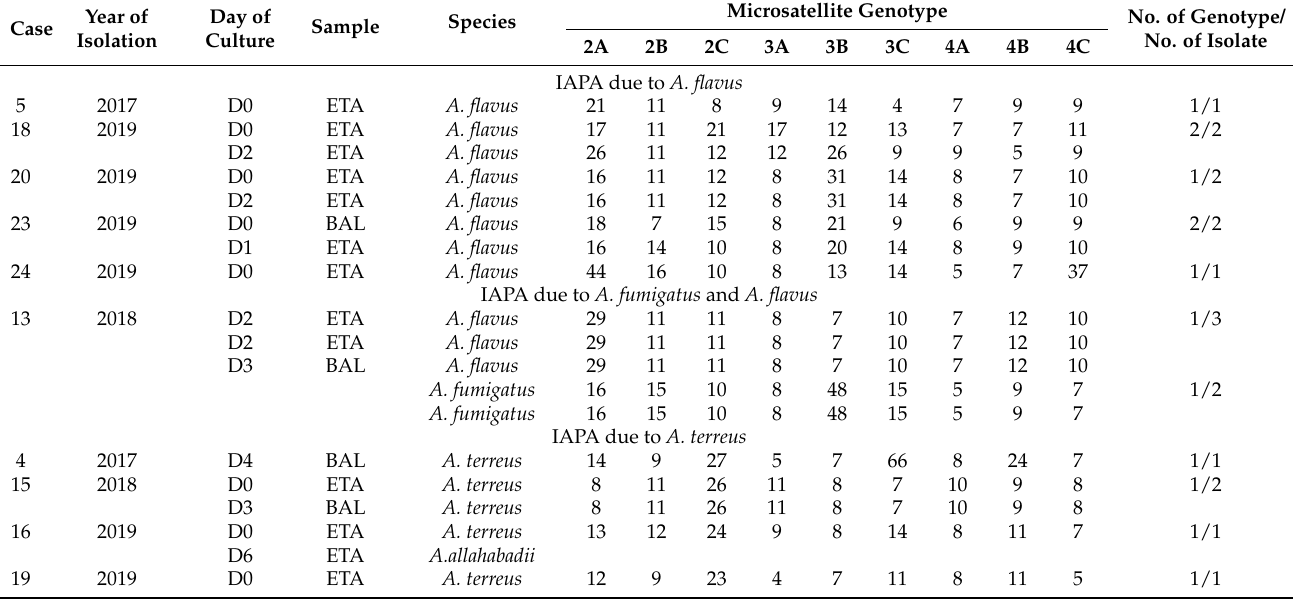
Abbreviation: BAL, bronchoalveolar lavage; “D0” and “Dn” indicate the day of and n days after the first isolation of Aspergillus species; ETA, endotracheal aspirate. a Azole-resistant A. fumigatus with wild-type cyp51A . b Azole-resistant A. fumigatus with TR 34 /L98H mutation in cyp51A